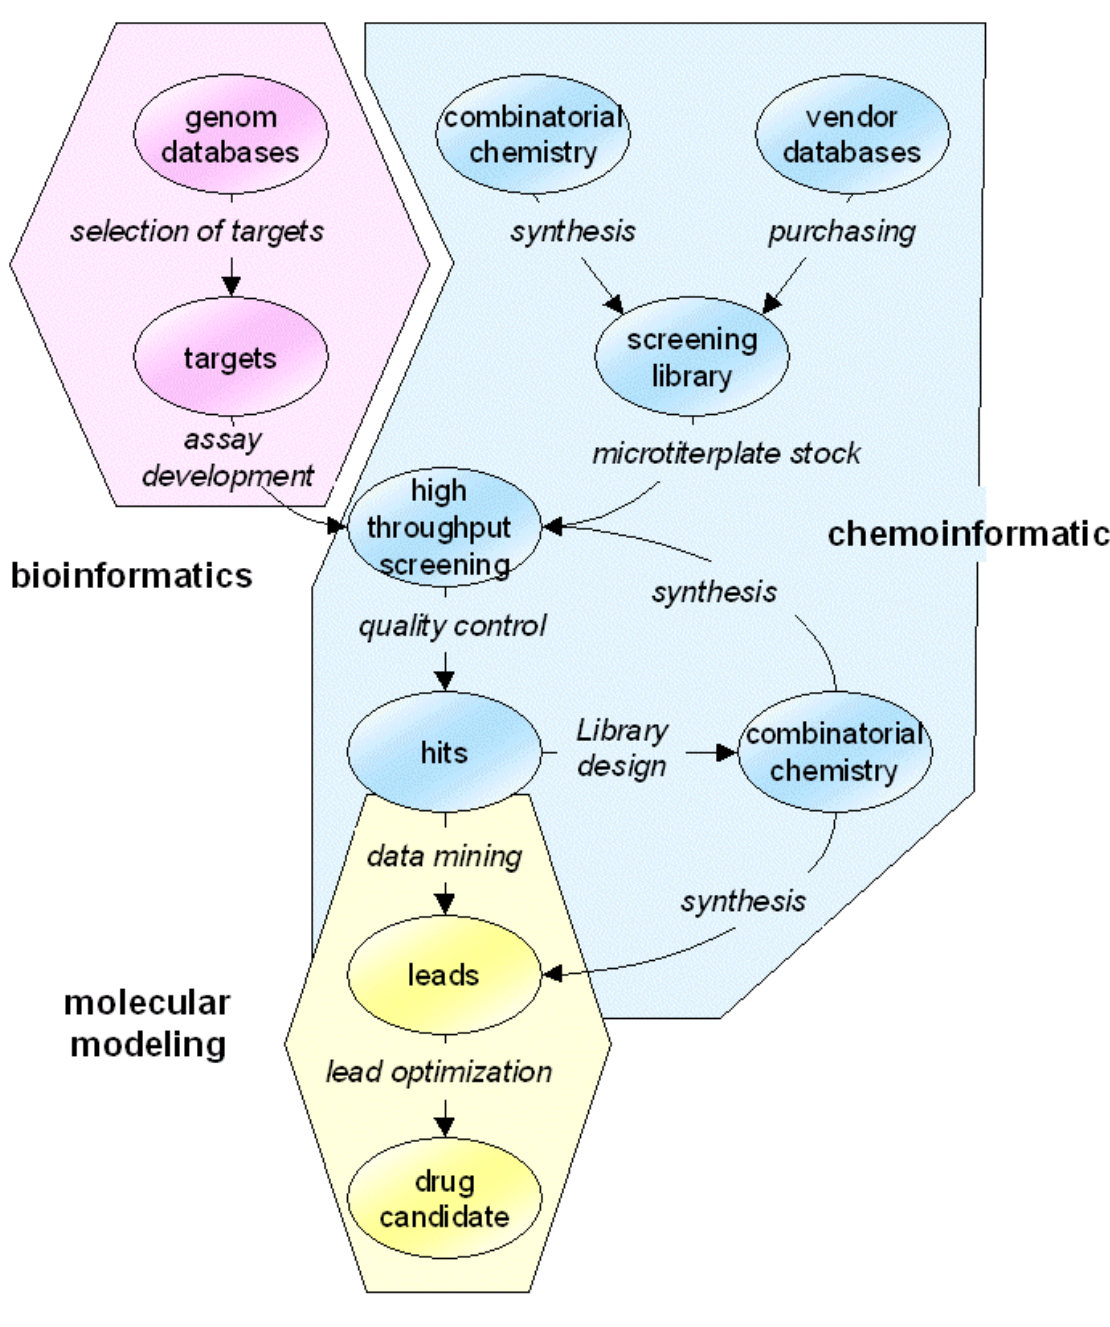
Figure 1: Simplified scheme of the preclinical drug discovery process. Every step in